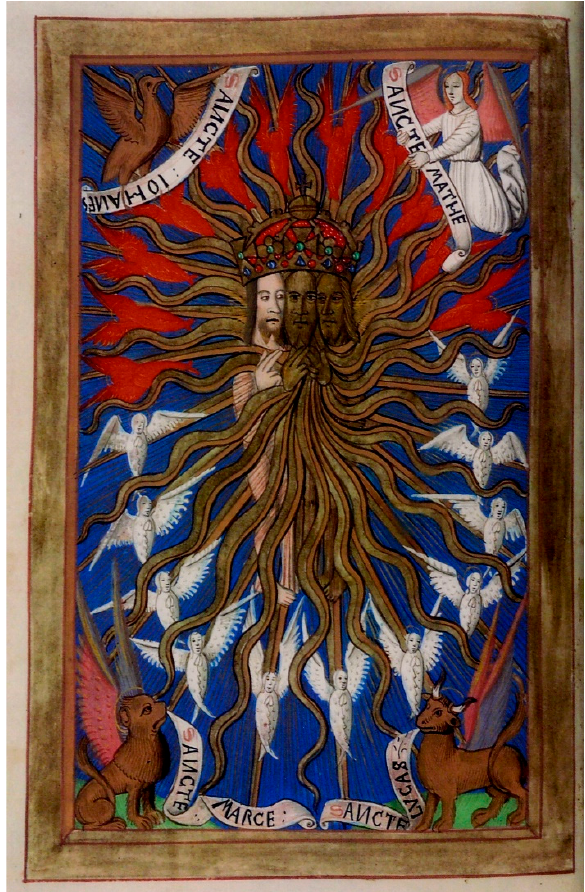
Figure 14. Holy Trinity, pair B of the Hours of the Earls of Ormond, ff. 8v and 27v, © British Library Board.